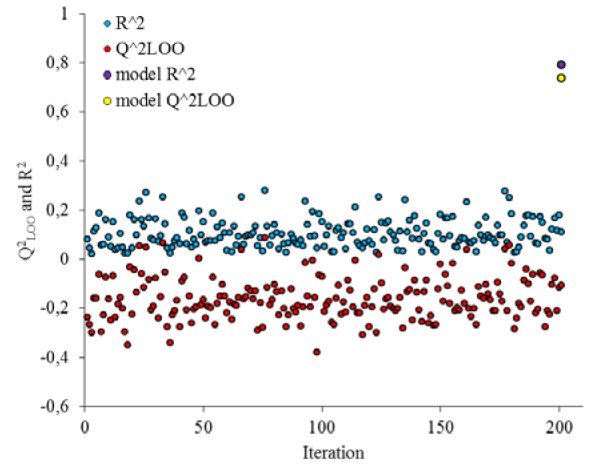
R2train and Q2LOO values after several Y-randomization tests for GA-MLR